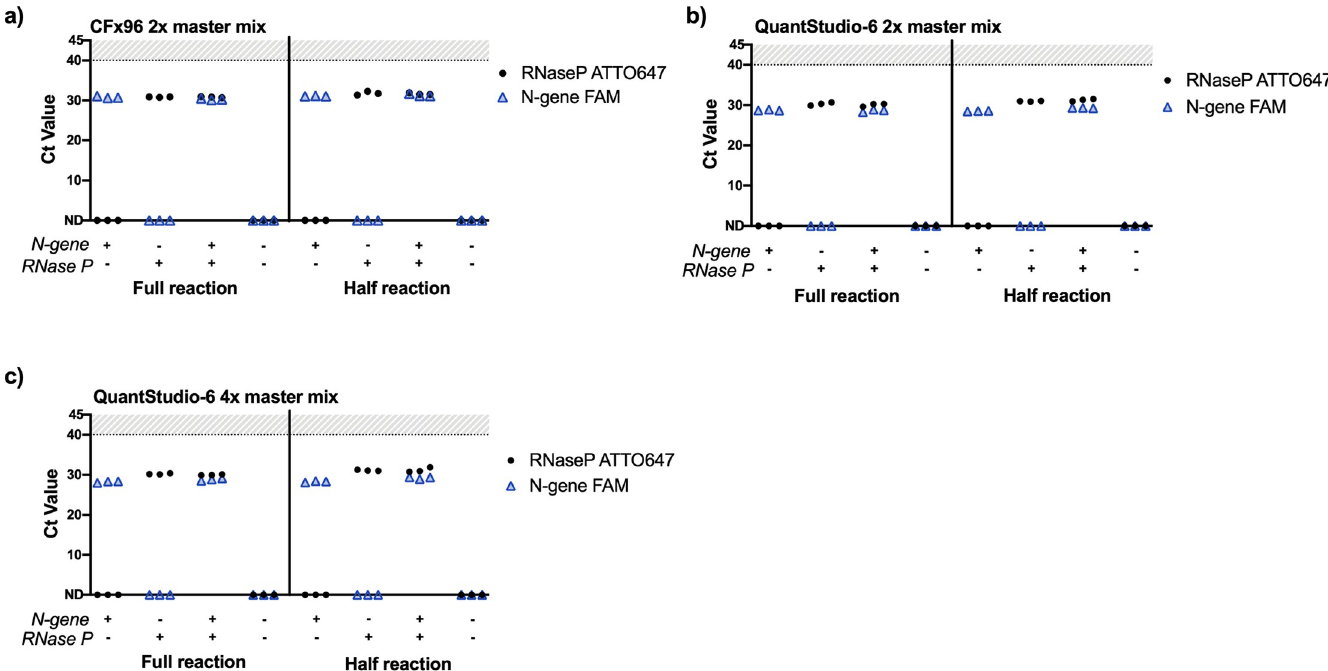
Fig 1. Implementation and adaptation of the Saliva Direct RT-qPCR assay to detect SARS-CoV-2 N1 and human RNase P with the QuantStudio-6. a) Full and half reaction volumes on the CFx96 with 2x master mix, b) Full and half reaction volumes on the QuantStudio-6 with 2x master mix, c) Full and half reaction volumes on the QuantStudio-6 with 4x master mix. Samples which failed to amplify are denoted as “not detected” (ND). Plasmid DNA was added directly into the master mix at 200,000 copies/mL (2-4x Saliva Direct limit of detection) in triplicate. Full reactions (15 μ L master mix with 5 μ L sample input), half reactions (7.5 μ L master mix with 5 μ L sample